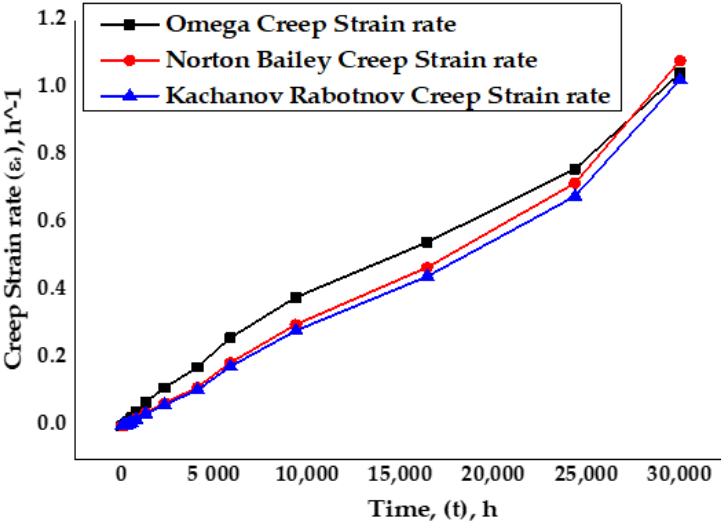
Figure 13. Analytical Omega model vs Norton–Bailey and Kachanov–Rabotnov creep strain rates.